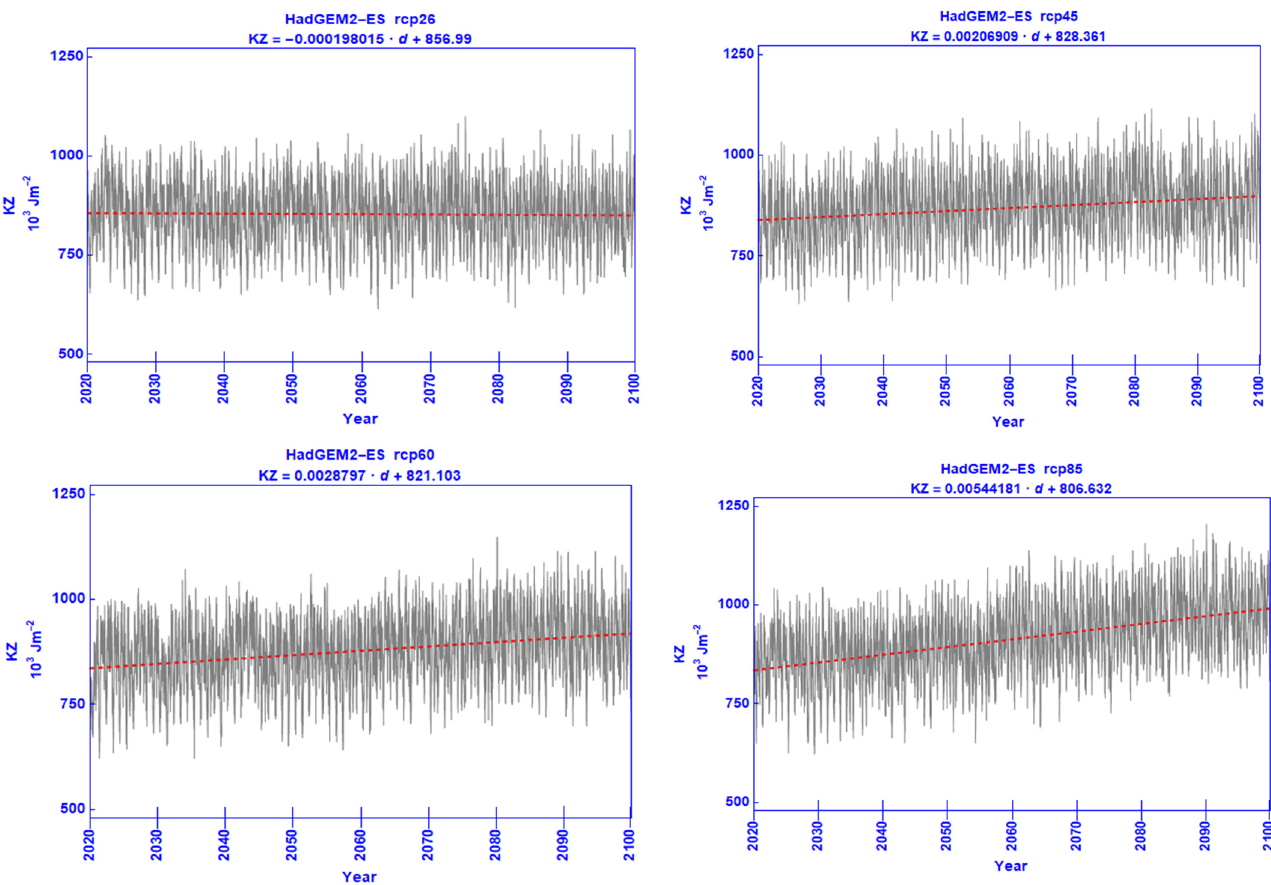
Figure 5. Same as Figure 3 but for KZ .